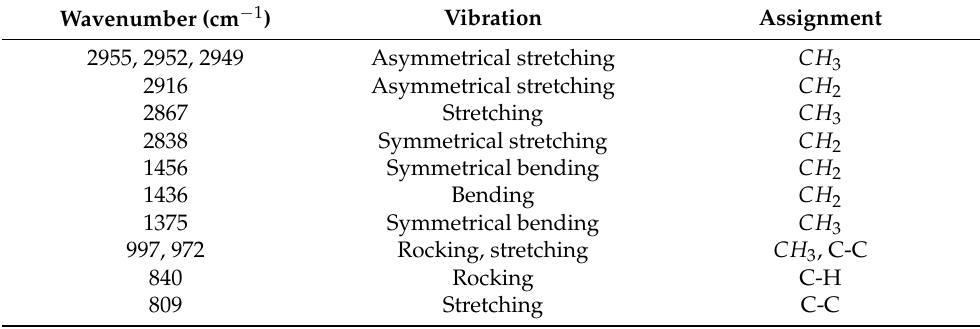
Table 3. FTIR absorption bands of